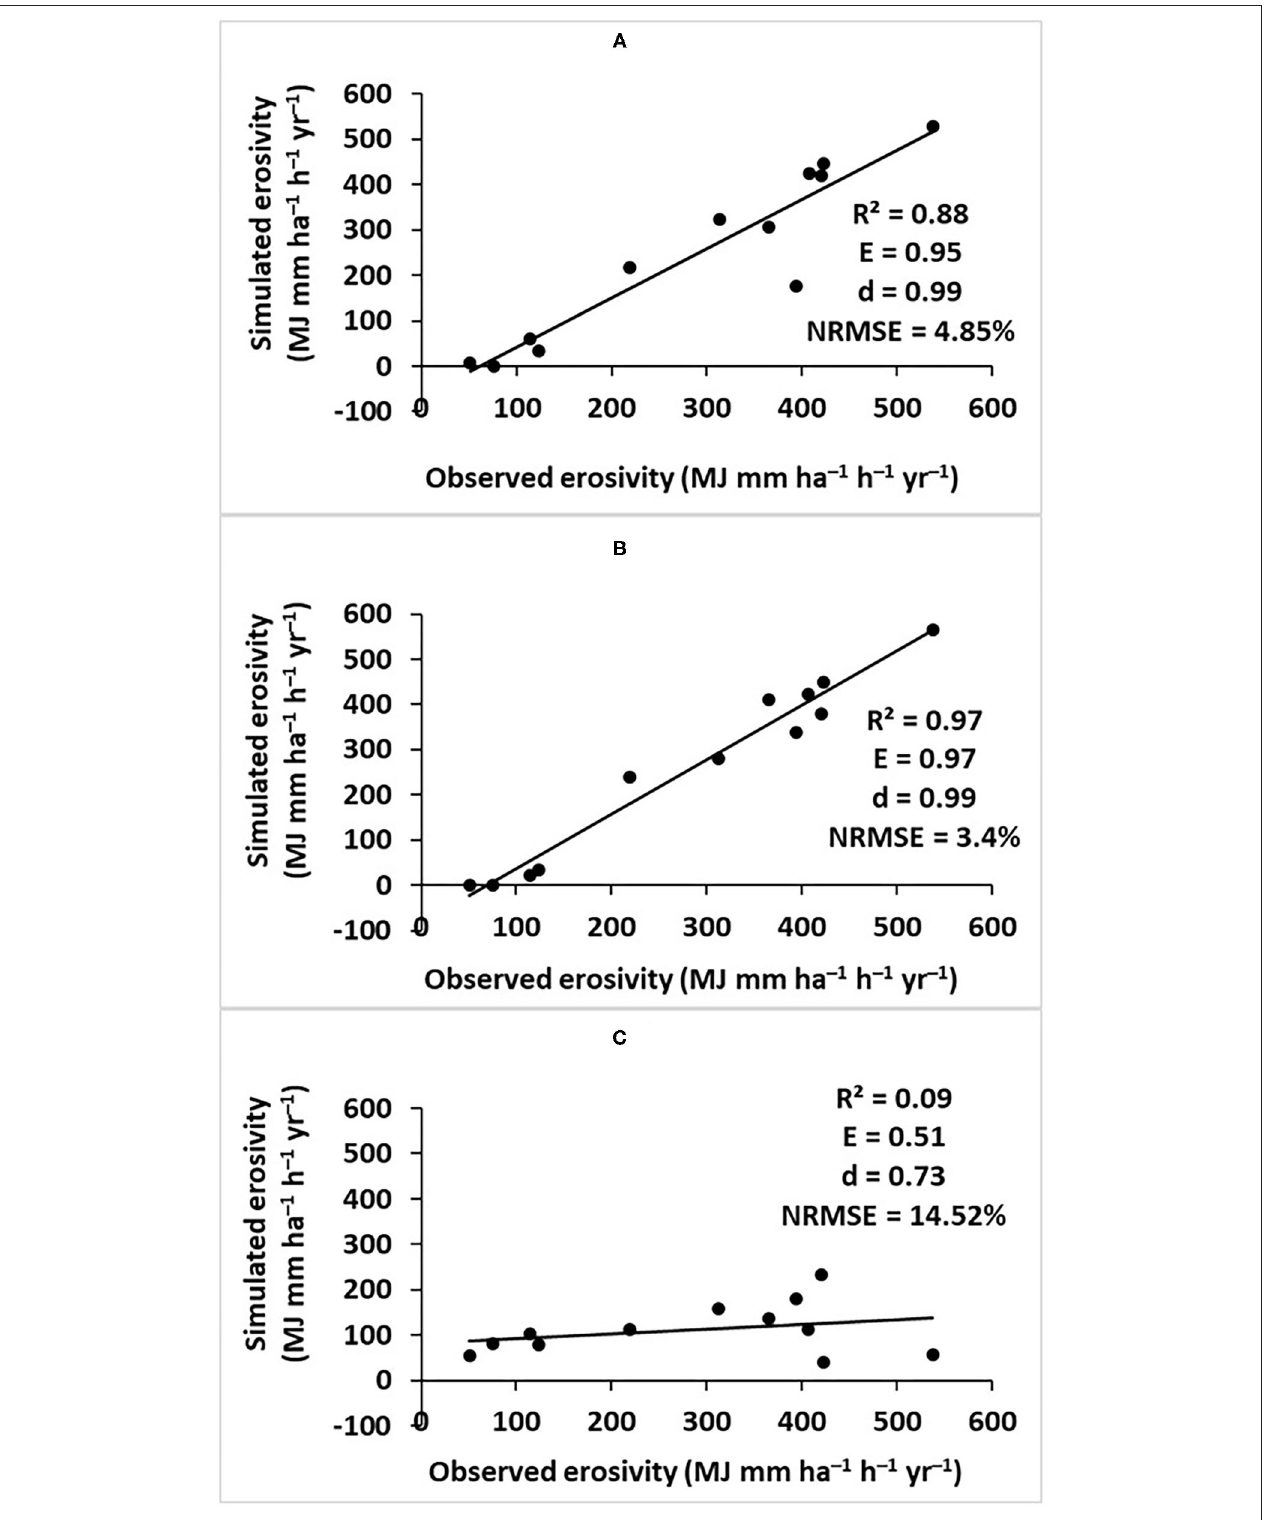
FIGURE 4 | Performance evaluation of regional climate models including (A) CCCma-CanESM2, (B) GFDL-ESM2M, and (C) HadGEM2-ES.